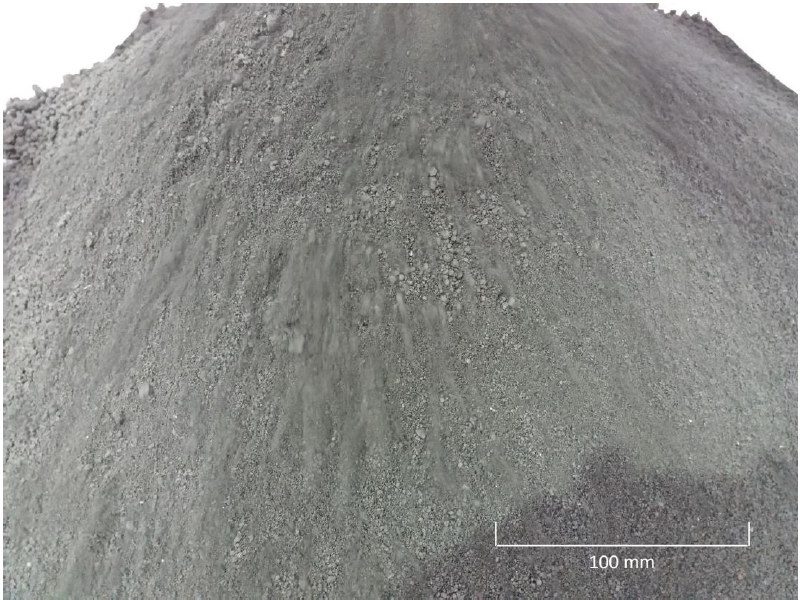
Figure 8. Deagglomerated river sediment.